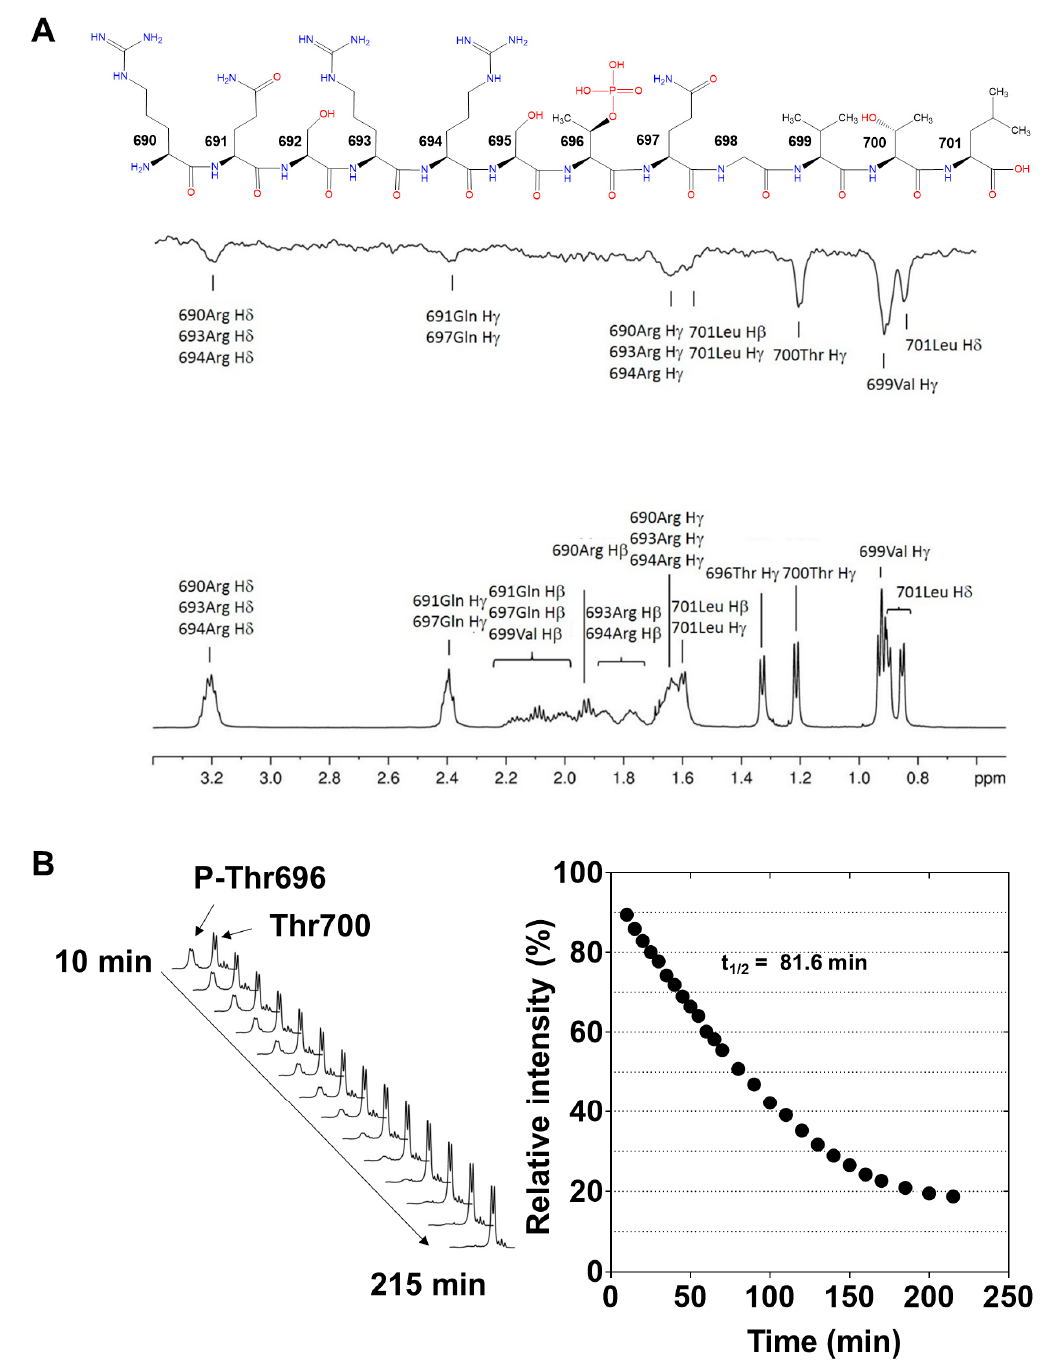
Figure 3. NMR spectroscopic investigations on the binding of P ‐ Thr696 ‐ MYPT1 690 − 701 to PP1c. ( A ): The structure of P ‐ Thr696 ‐ MYPT1 690 − 701 peptide is depicted (upper panel) and its 1 H ‐ NMR spectrum in D 2 O is shown (lower panel). Saturation transfer difference (STD) 1 H ‐ NMR spectrum of P ‐ Thr696 ‐ MYPT1 690 − 701 (1.3 mM) in the presence of 13.3 μ M recombinant PP1c (middle panel). PP1c α and PP1c δ expressed in E. coli and purified from the bacterial lysate were used with similar results. The representative data presented here were obtained with PP1c α and P ‐ Thr696 ‐ MYPT1 690 − 701 . ( B ): Dephosphorylation of P ‐ Thr696 ‐ MYPT1 690 − 701 followed by real ‐ time 1 H ‐ NMR experiment. Left: changes of the signal intensity of P ‐ Thr696 and Thr700 as a function of time. Right: the signal intensity of P ‐ Thr696 plotted against the time allows the determination of the half ‐ life (t 1/2 ) for the dephosphorylation of P ‐ Thr696 ‐ MYPT1 690 − 701 . The dephosphorylation of P ‐ Thr696 ‐ MYPT1 690 − 701 was followed by real ‐ time time ‐ de ‐ pendent 1 H ‐ NMR measurement. A gradual decrease in the signal intensity of the methyl